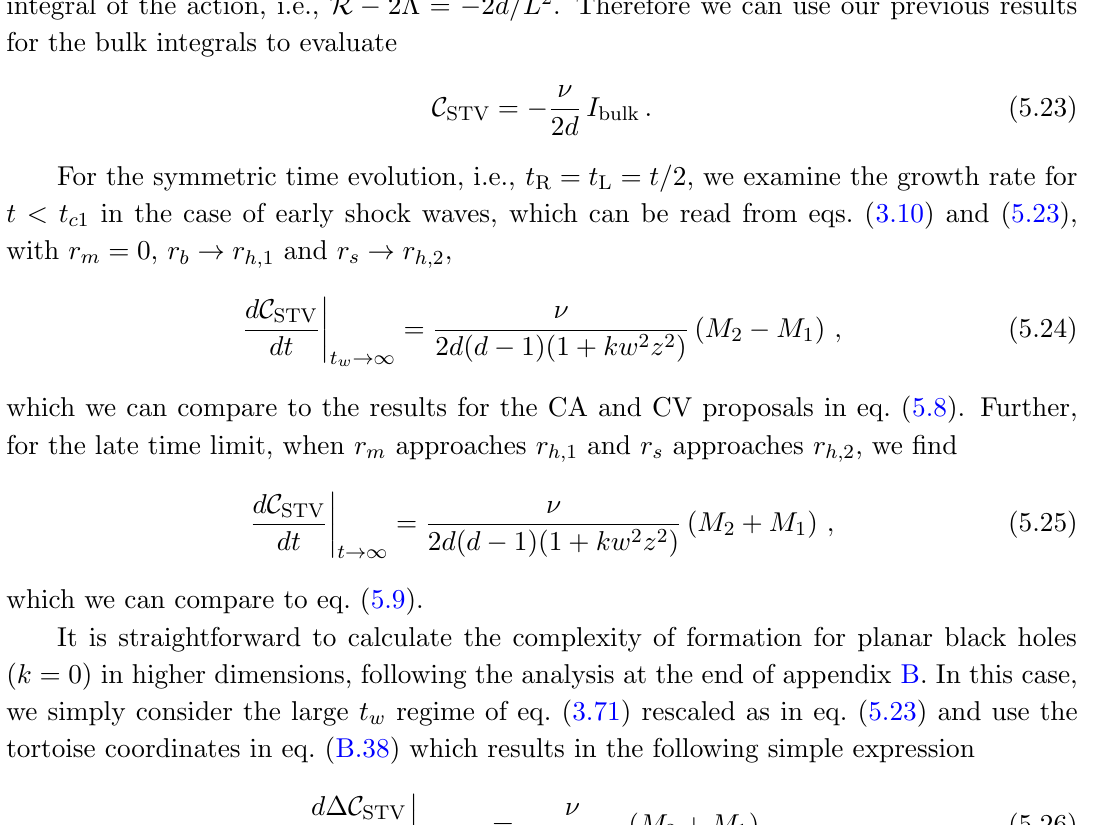
( M 1 + M 2 ) is plotted 2 M 1 ) t w and matches the (cid:0)